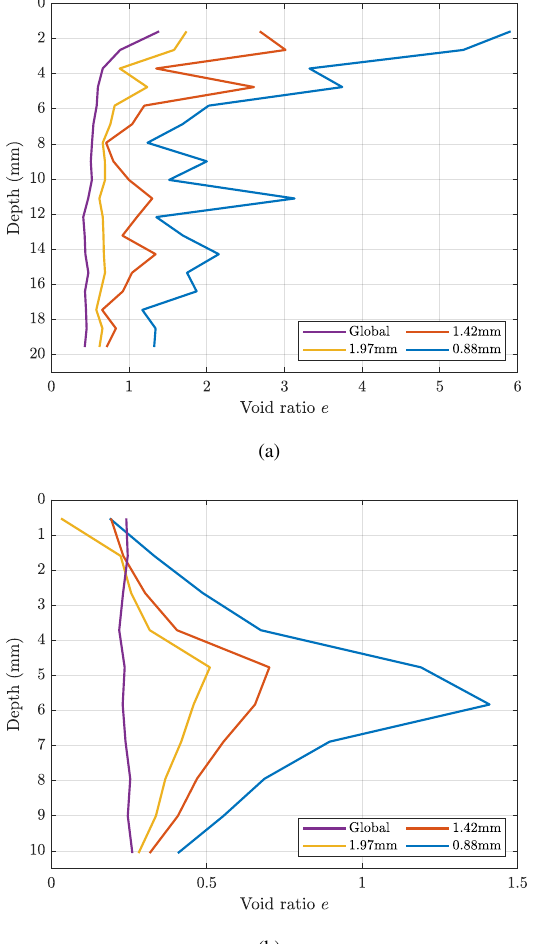
Figure 5. Normalised root volume ratio profile for coarse and fine glass